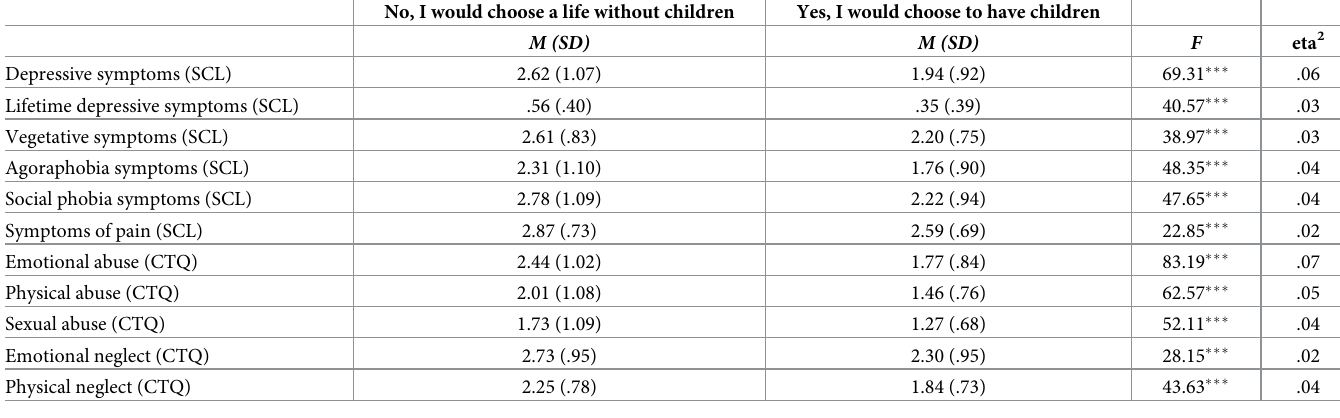
Table 5. Mean differences between the parents regretting and not regretting parenthood in Study